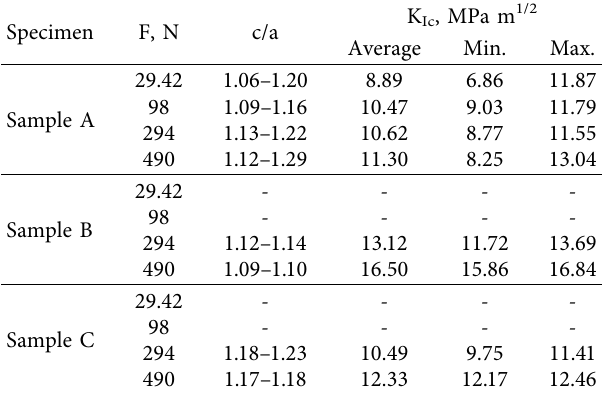
Figure 6. The fracture toughness index was calculated by